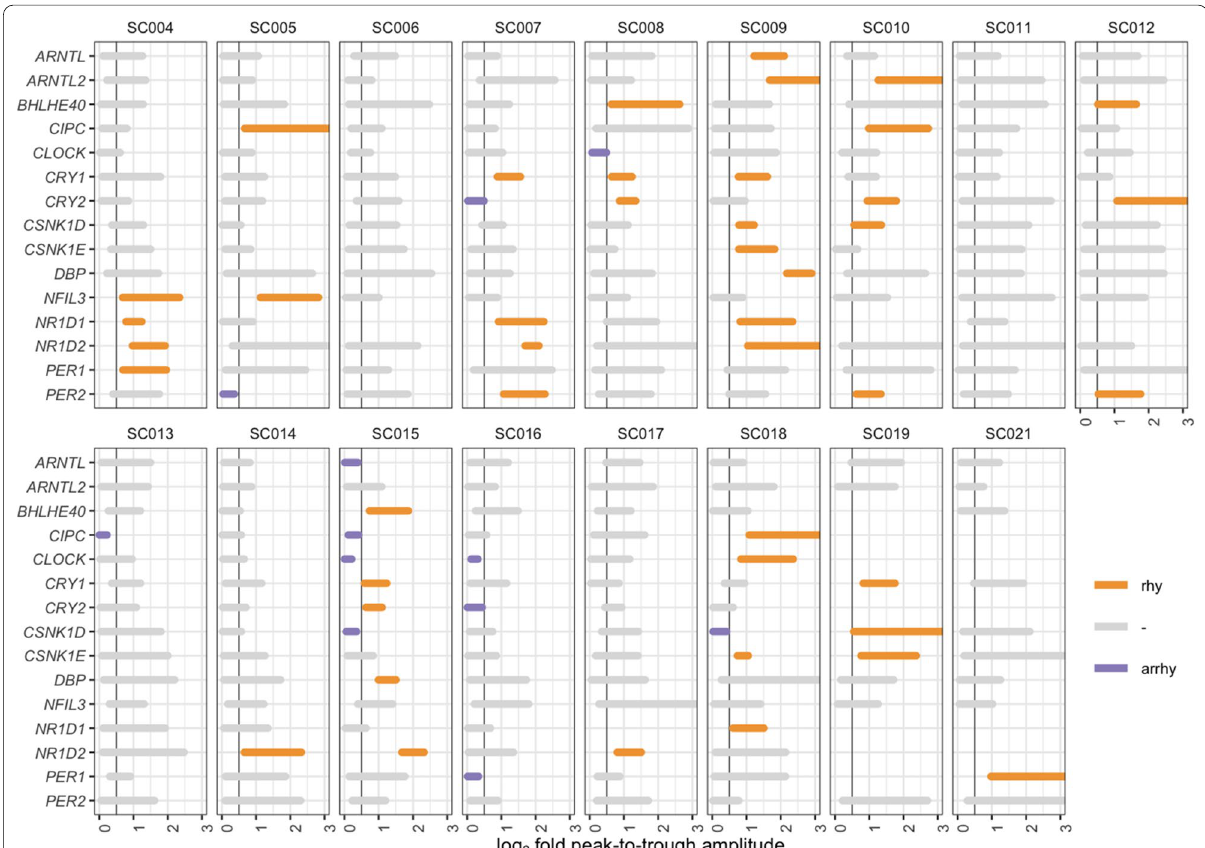
Fig. 3 Quantification of rhythmicity of clock genes in septic shock patients. Confidence intervals (CI) on the rhythm amplitudes (peak to trough on the log 2 scale) of gene expression based on harmonic regression and bootstrapping are visualized as horizontal bars. The CIs include the true amplitude of the clock gene with a 95% probability. The color of the bars indicates whether the rhythms are present (orange), absent (violet) or data are inconclusive (grey). The vertical line shows the minimum amplitude that is deemed biologically relevant. Bars are missing for certain clock genes that did not satisfy the inclusion